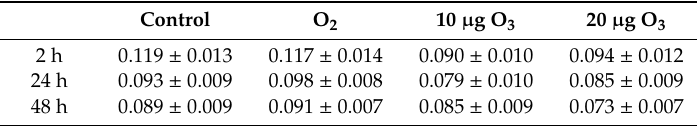
Mitochondrial area values (mean ± SE) according to treatment and incubation time